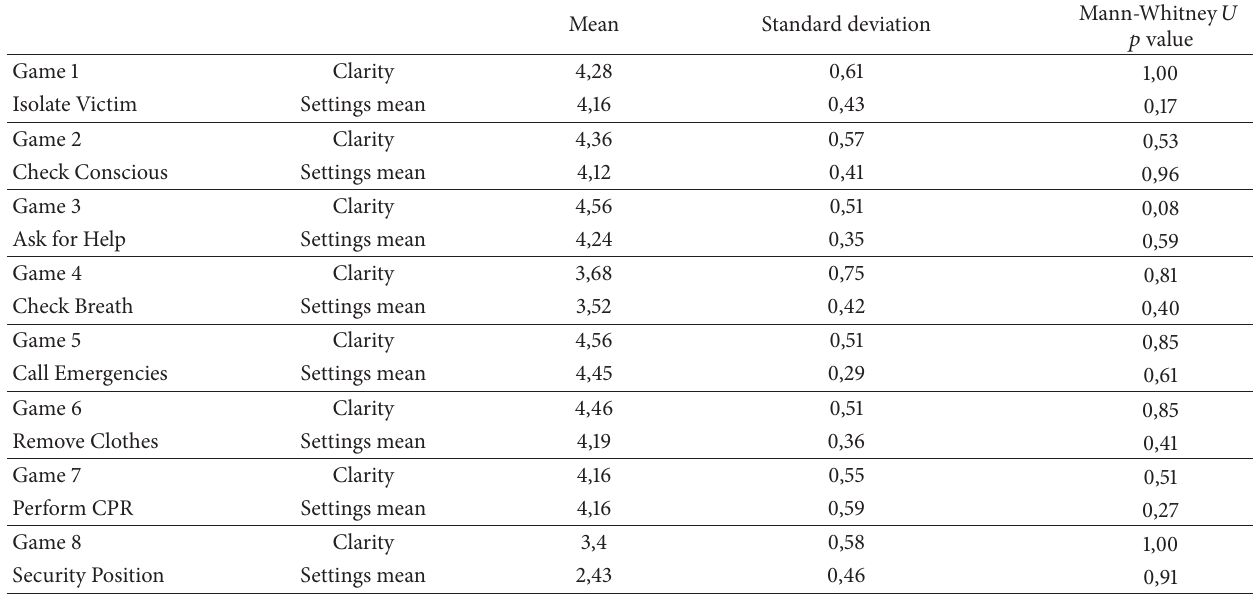
Table 2: Mean and standard deviation of 25 testers’ answers related to clarity of instructions and three settings of the game: the aesthetics of scenarios, the playability, and the enjoyability of each mini